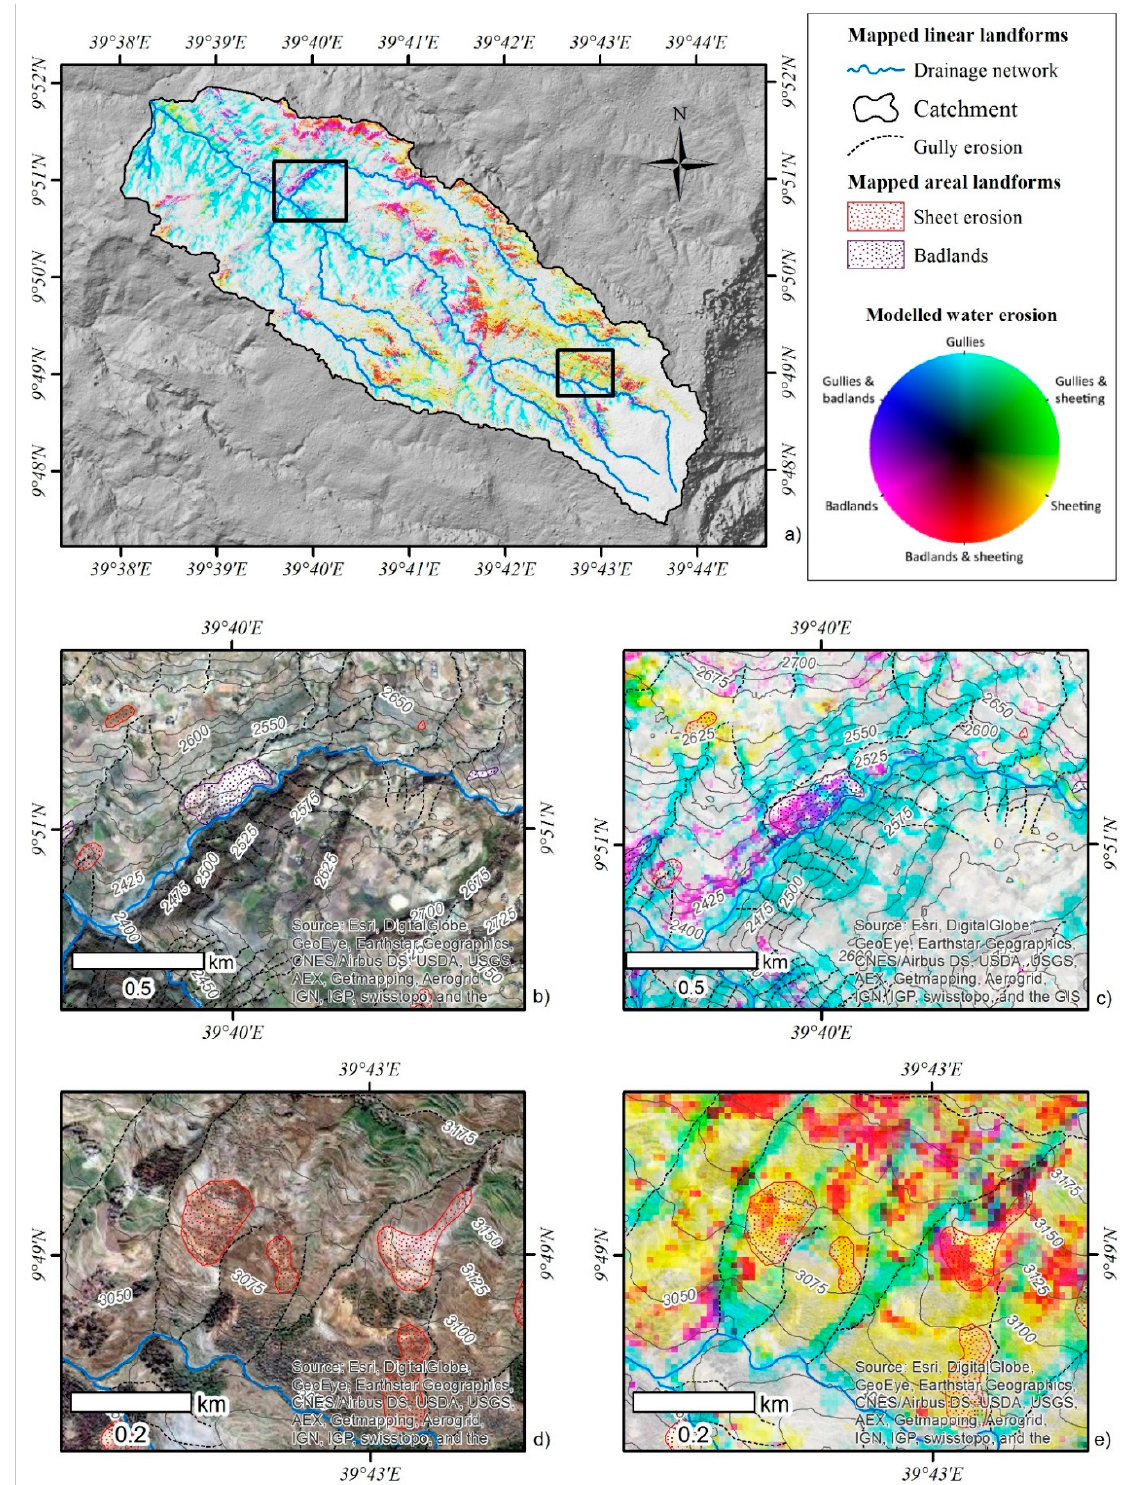
Figure 8. Water erosion model: ( a ) combined water erosion susceptibility map; ( b ) Zoom of the water erosion inventory in area A; ( c ) Zoom of the combined susceptibility model in area A; ( d ) Zoom of water erosion inventory in area B; ( e ) Zoom of the combined susceptibility model in area B.